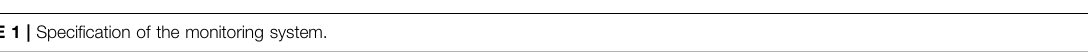
TABLE 1 | Speci fi cation of the monitoring